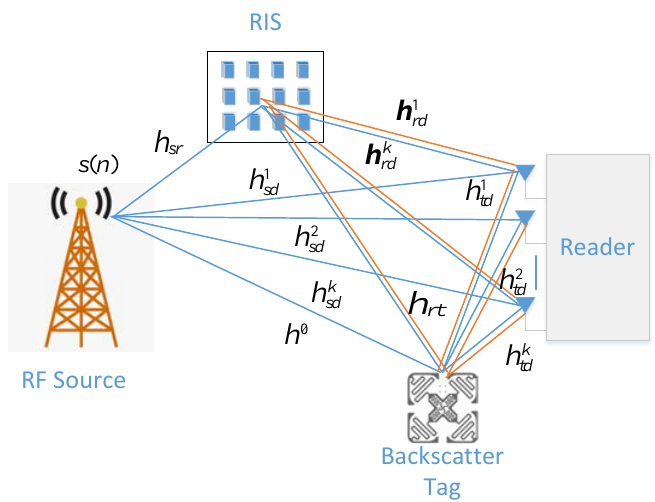
Figure 1. RIS-assisted AmBC